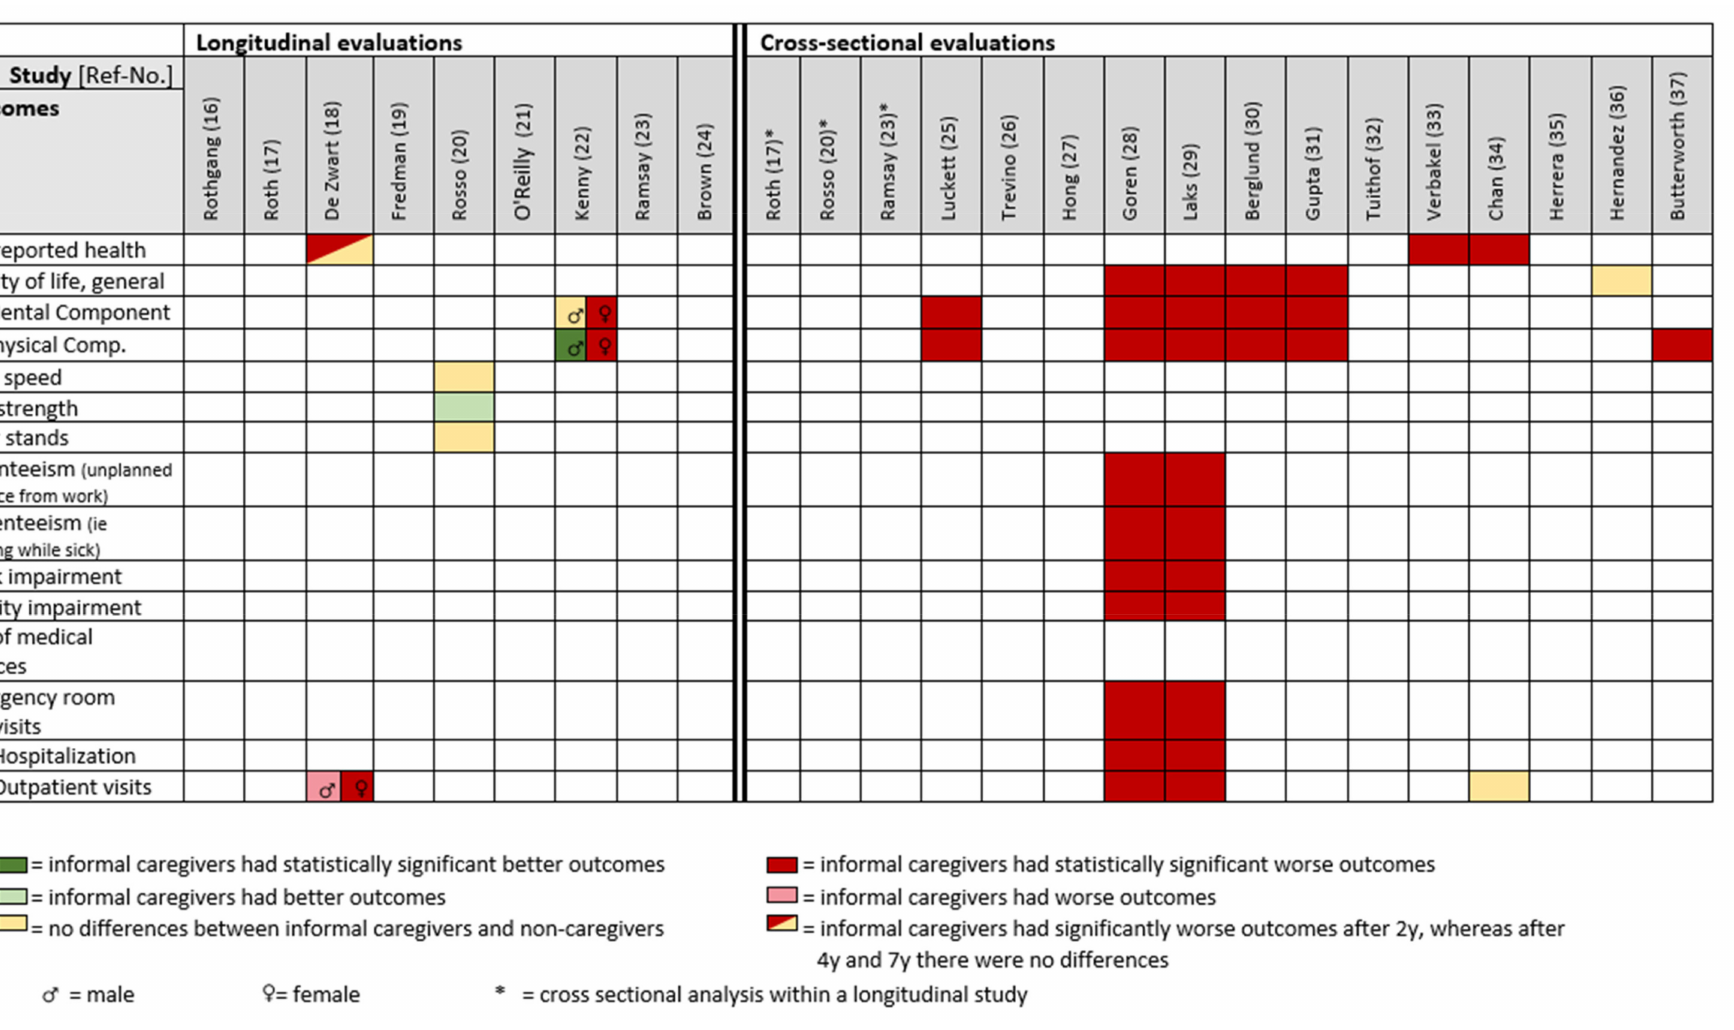
Figure 4. Simplified overview comparing self-reported general health-related outcomes and health care utilization between informal caregivers and non-caregivers in population-based